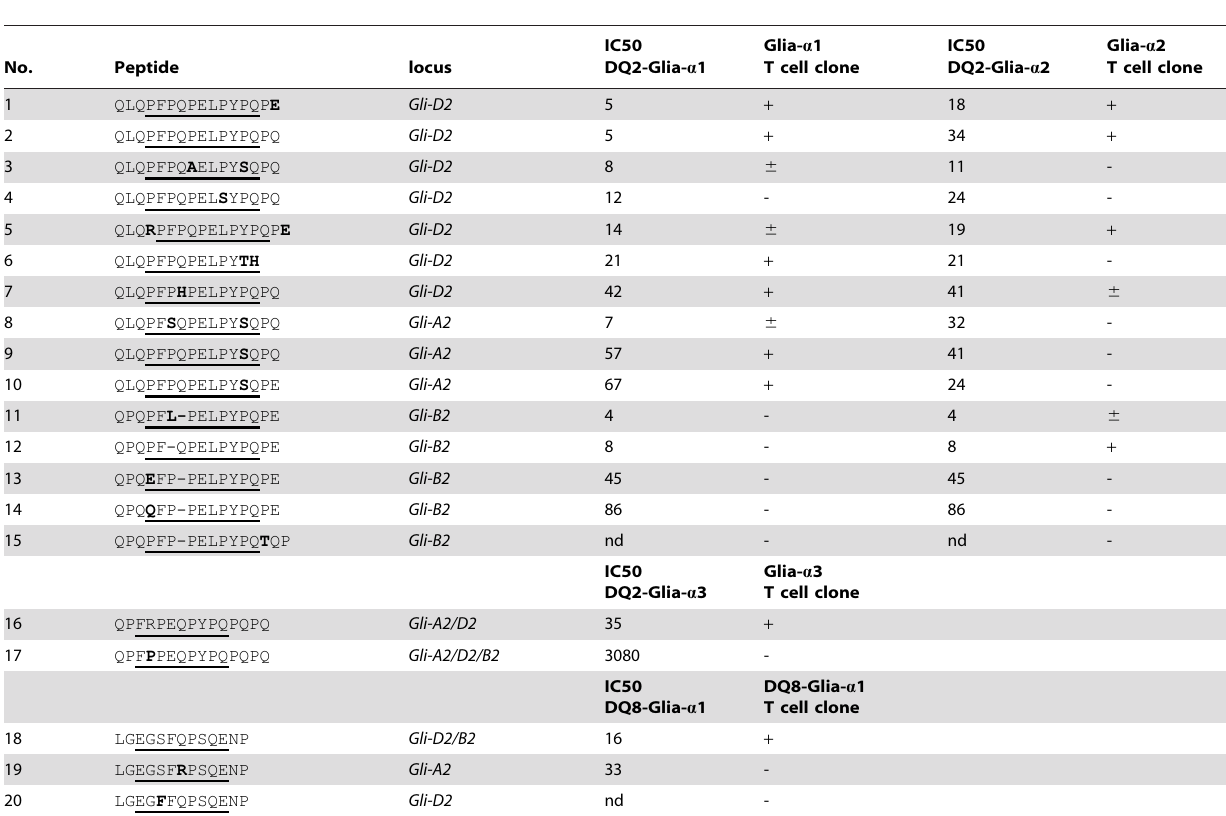
Table 6. T cell proliferation and HLA-DQ2 binding capacity of DQ2-Glia- a variants.